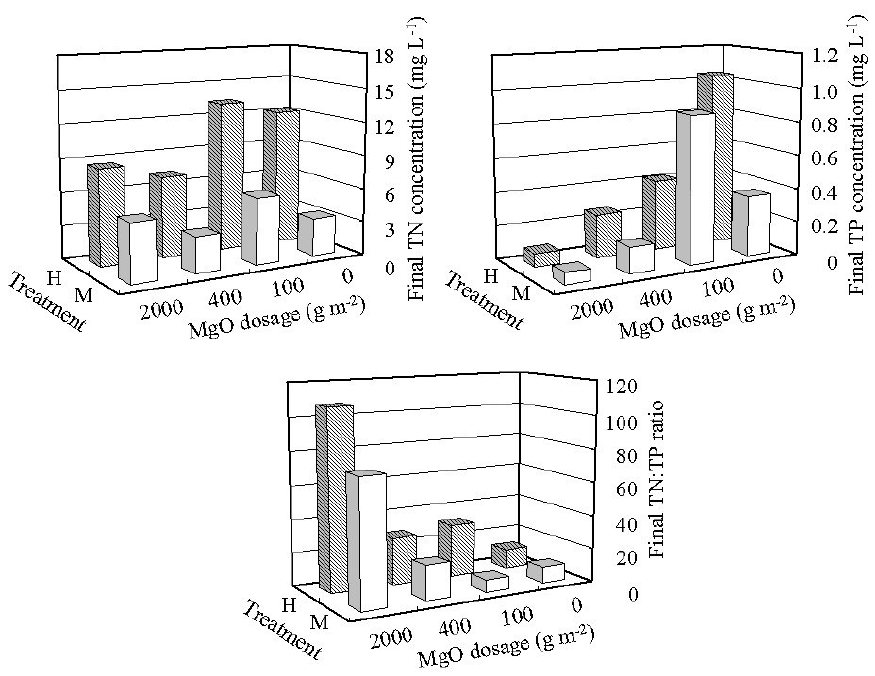
FIGURE 3. Changes in the final TN and TP concentrations, and the TN:TP ratios through the nutrient elusion test (microcosm). N, nontreated sediment; M, MgO-treated sediment; D, DAF-treated sediment; H, hybrid-treated sediment.